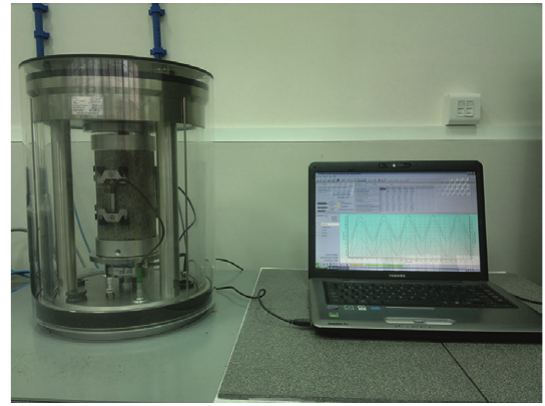
Figure 2. Specimen during the test in Simple Performance